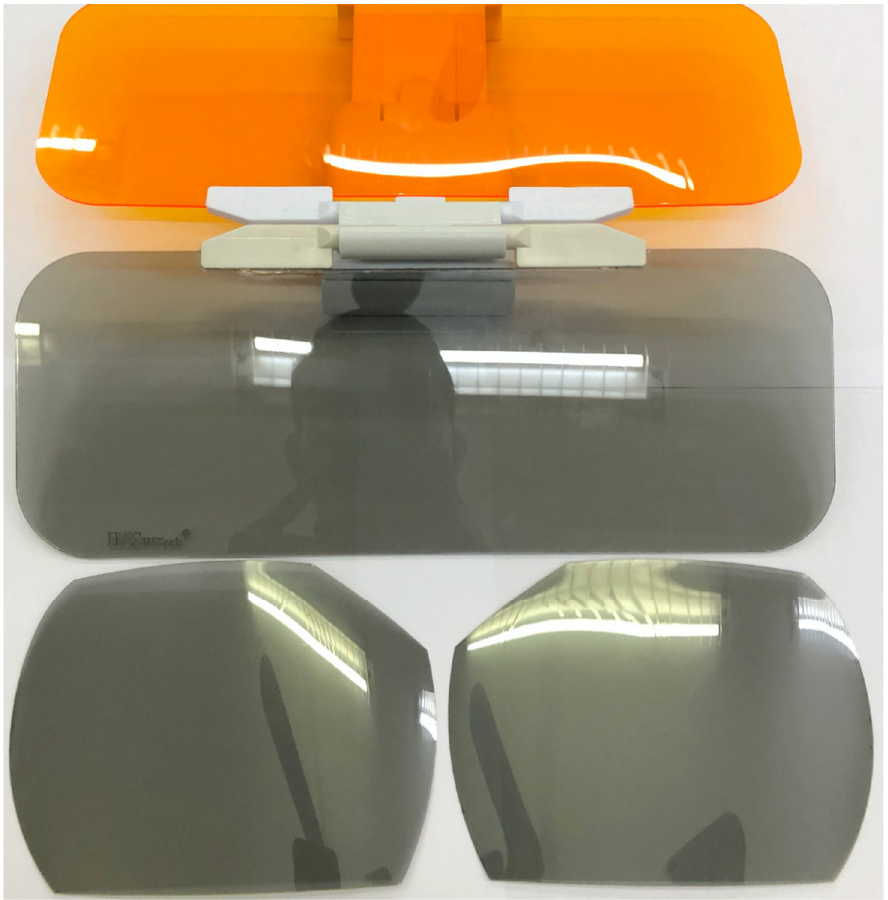
Figure 1. The polarizing fl ip plate ( top ) and headlight fi lters ( bo tt om ) used in our experiment.